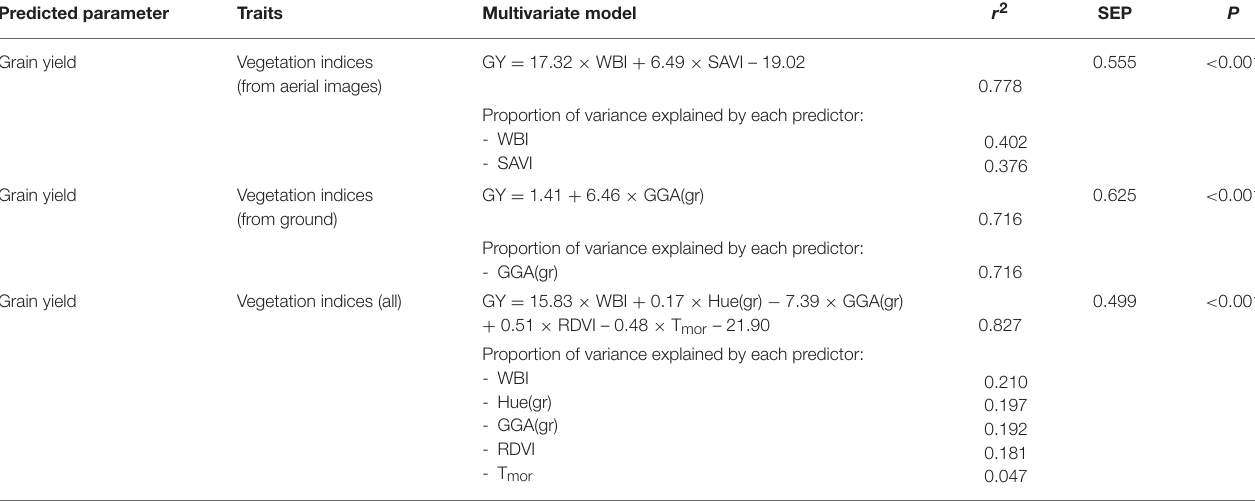
TABLE 4 | Multivariate regression models explaining grain yield variation from vegetation indices (VIs) across genotypes under different N supplies. Predicted